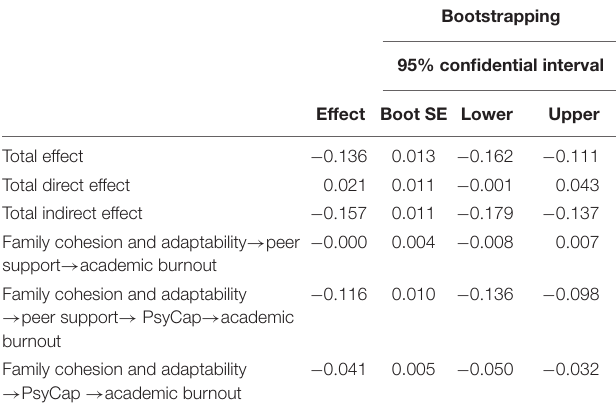
TABLE 4 | Total, direct, and indirect effects of family cohesion and adaptability through peer support and positive psychological capital on academic